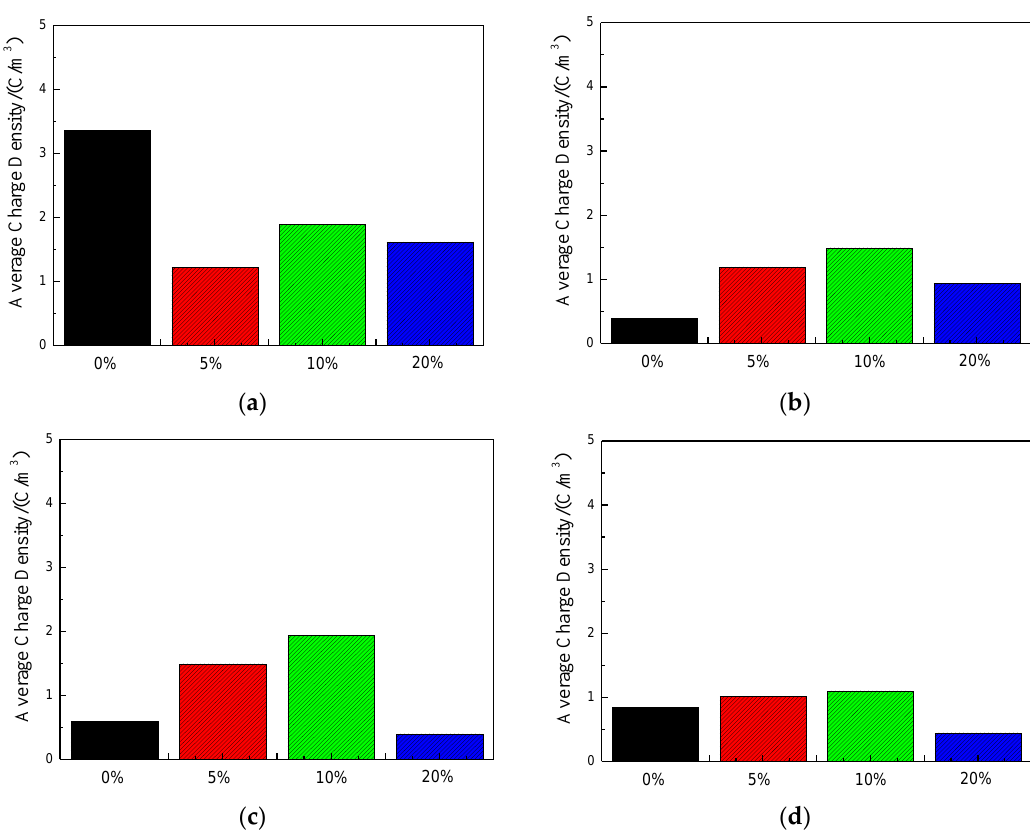
Figure 8. Average charge density for each sample at 40 kV/mm field intensity. ( a ) Sample 1; ( b ) Sample 2; ( c ) Sample 3; ( d ) Sample 4.